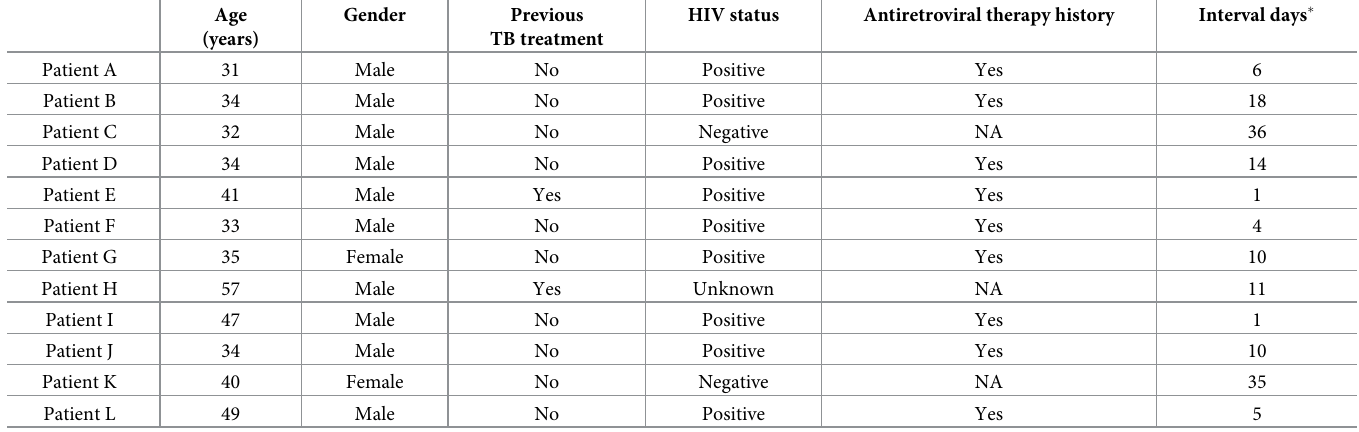
Table 3. Newly diagnosed tuberculosis patients (N =